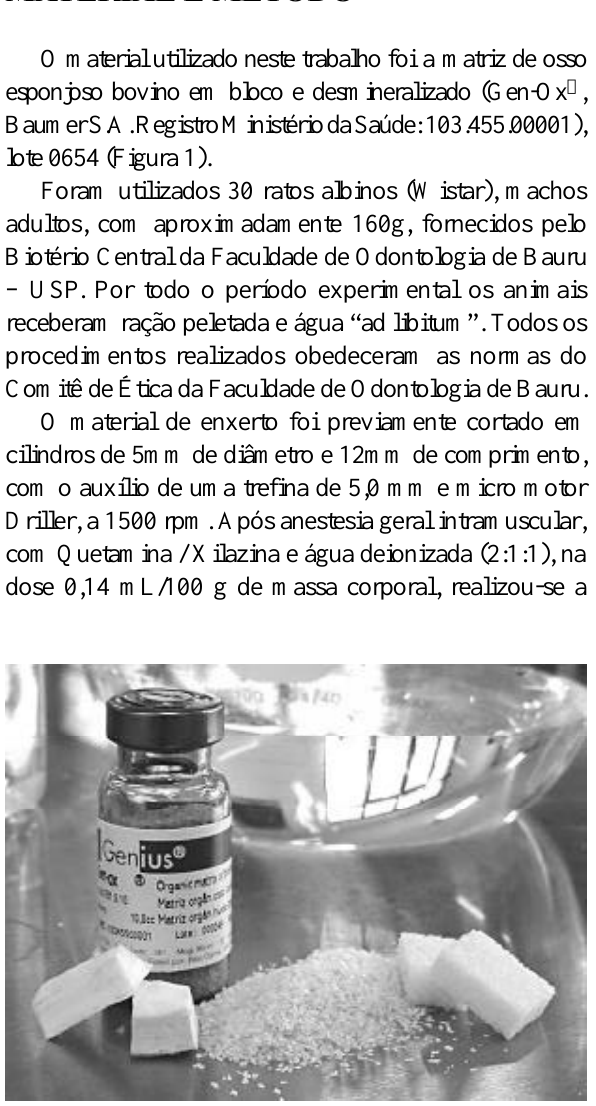
FIGURA 1 - Bloco de Osso Medular Orgânico, produzido a partir de ossos longos de bovinos. Proteínas inorgânicas e gorduras foram removidas após tratamento com solventes